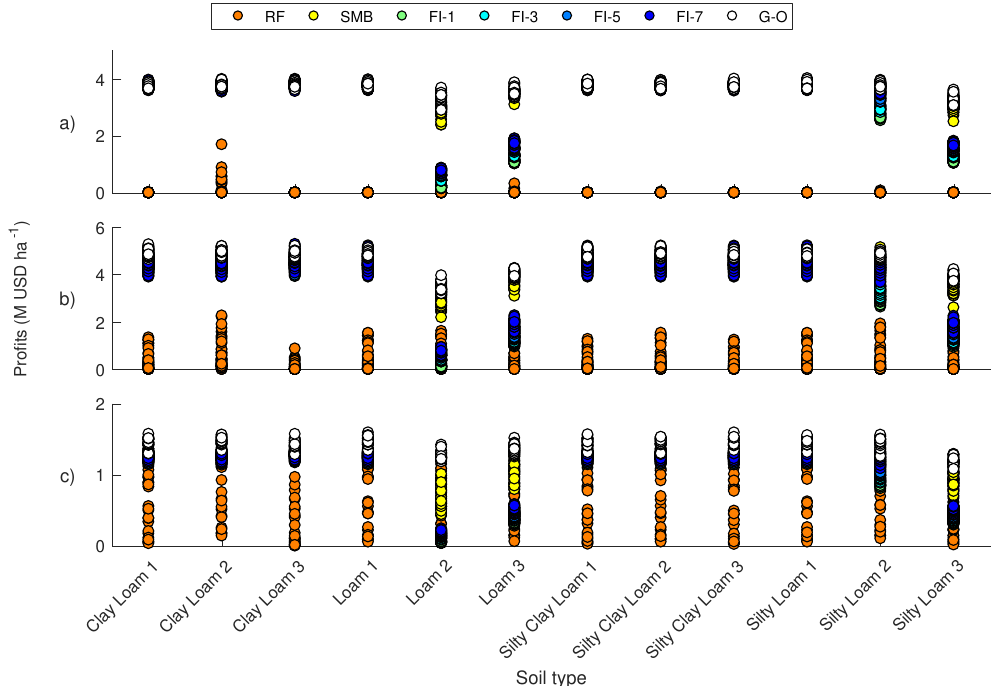
Figure 7. Profits for maize ( a ), sugar beet ( b ), and wheat ( c ) as functions of soils with low (1), medium (2), and high (3) bulk densities under different irrigation strategies: RF: Rainfed; SMB: Soil moisture-based; FI: Fixed interval every 1, 3, 5, and 7 days; and G-O: GET-OPTIS considering simulated values from 1965 to 2016